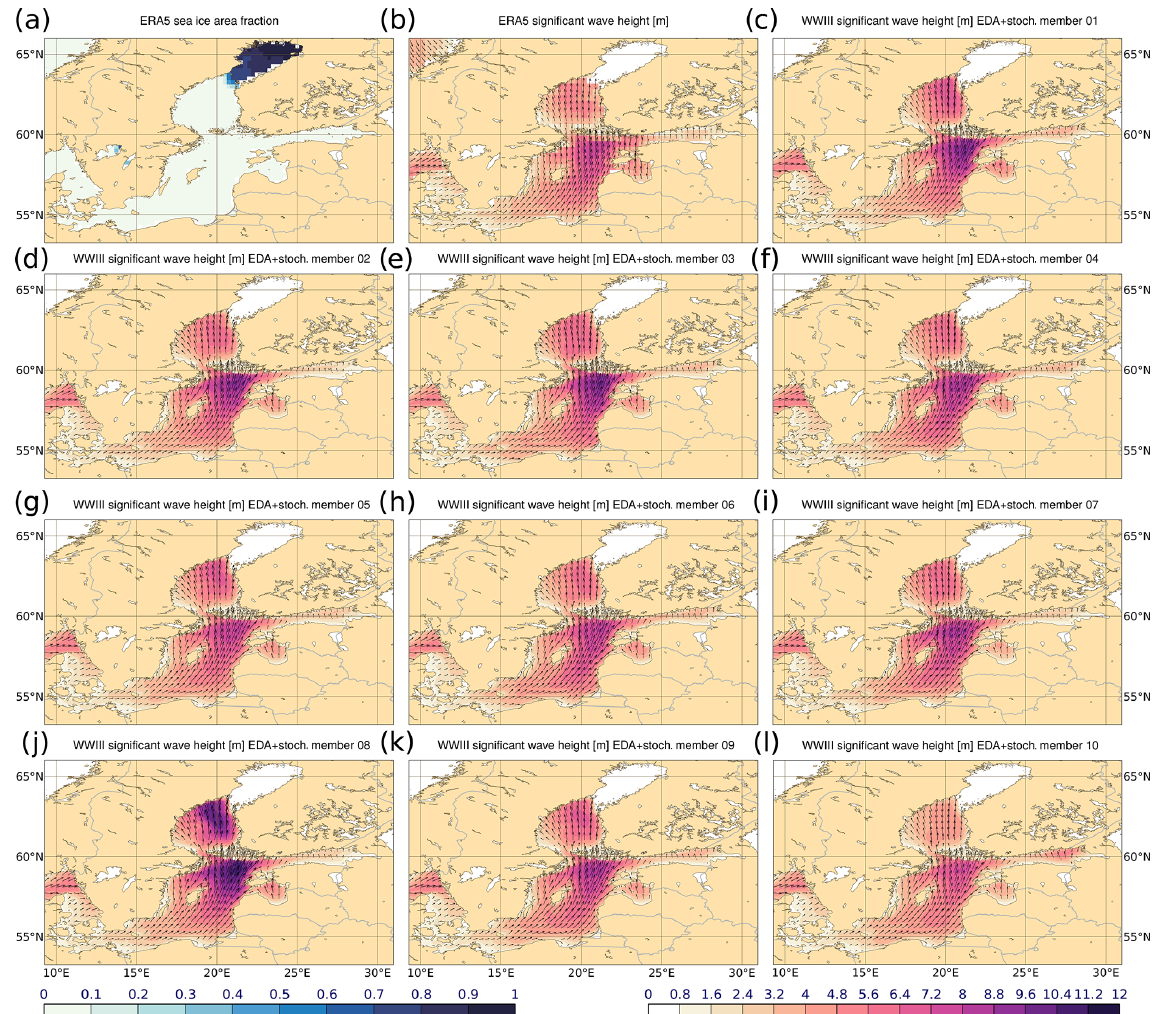
Figure 7. (a) ERA5 sea ice area fraction (0–1); (b) ERA5 ECWAM significant wave height (m) with direction in meteorological conven- tion and (c–l) 10 WAVEWATCH III ® members driven by WRF ensemble initialized from 10 ERA5 EDA members at 21 February 2002 12:00UTC with SPPT and SKEB. Shown are results for 22 February 2002